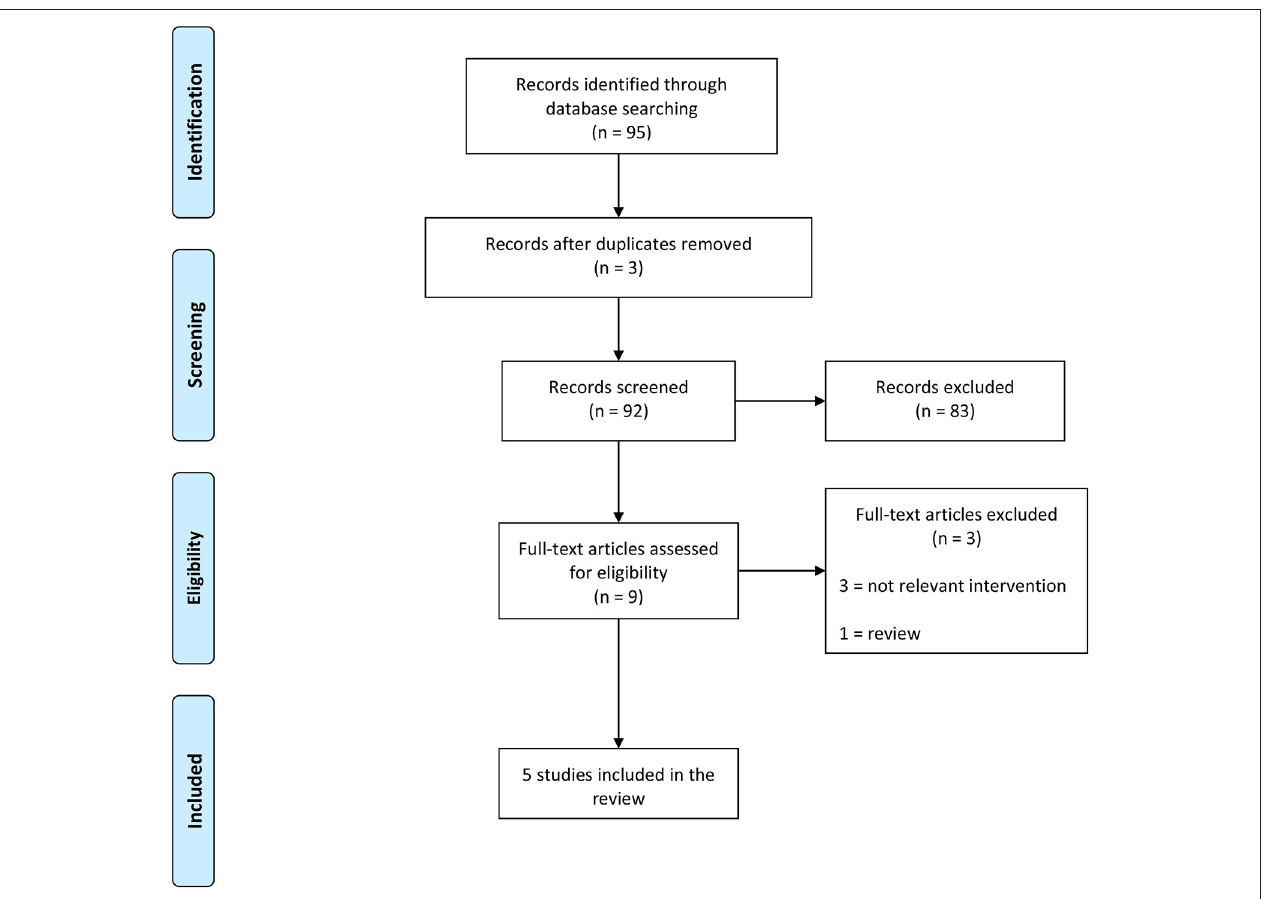
FIGURE 1 | PRISMA